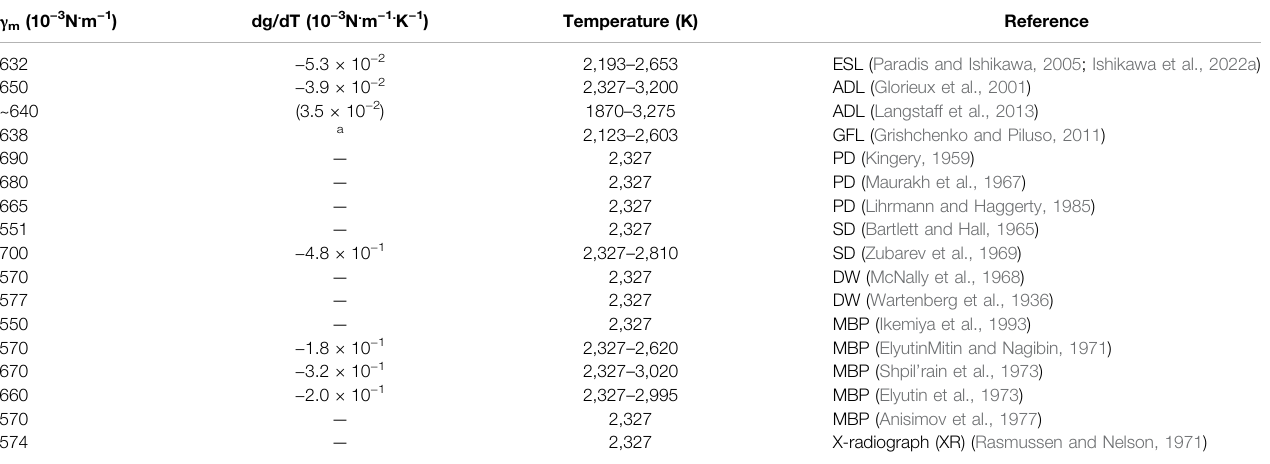
TABLE 2 | Surface tension of molten Al 2 O 3